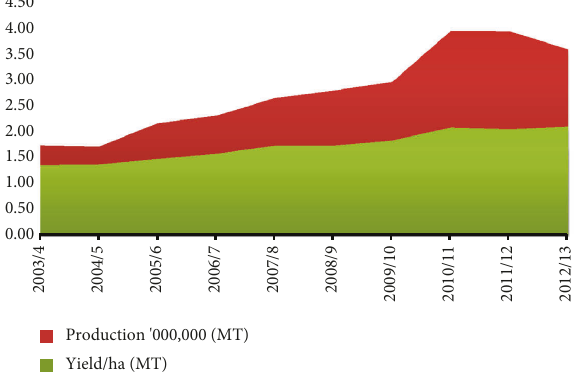
Figure 1: World sorghum producers (averaged 2006–2012) Source: CSA reports from 2003 to 2013.